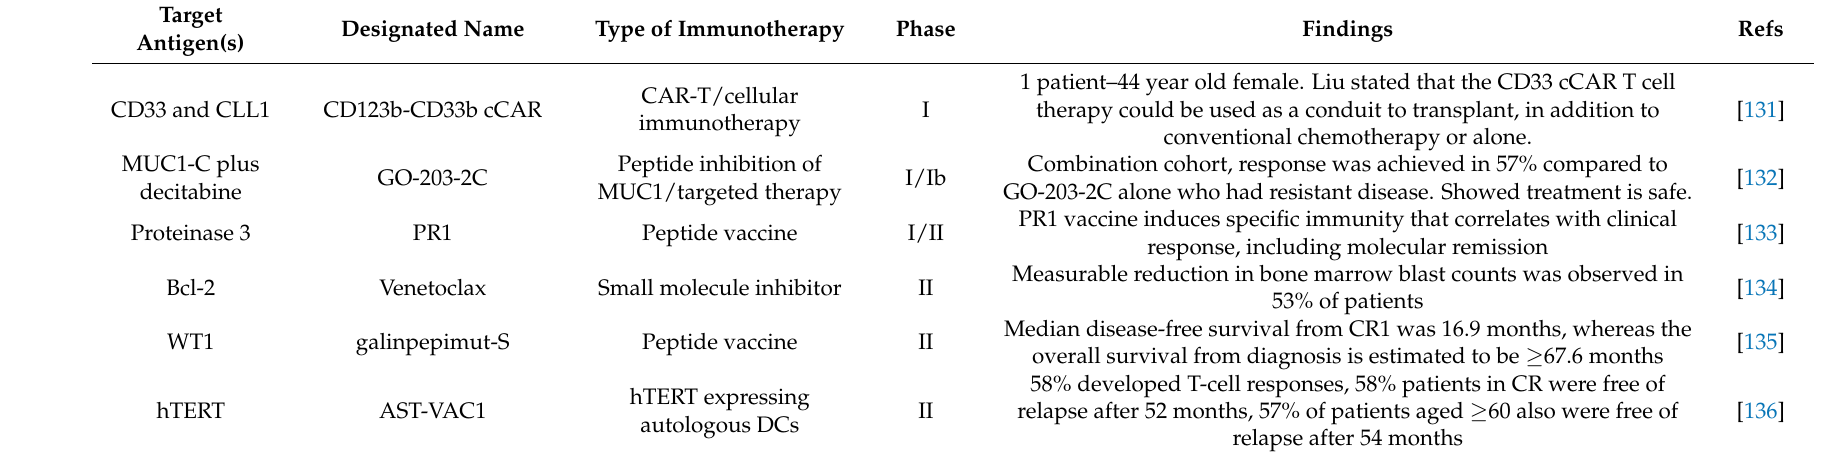
Table 1. Some examples of current clinical trials involving antigenic targets in acute myeloid leukaemia